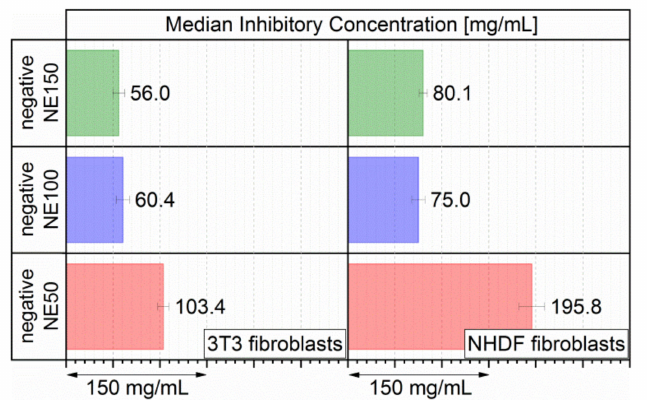
Figure 7. IC50 as the total mass of the three negatively surface-charged nanoemulsions (DiR loaded MCT, PG, MHS + aqueous phase) per mL cell culture media on 3T3 and NHDF fibroblasts after 24 h incubation, determined by three individual incubated batches (eight replicates per